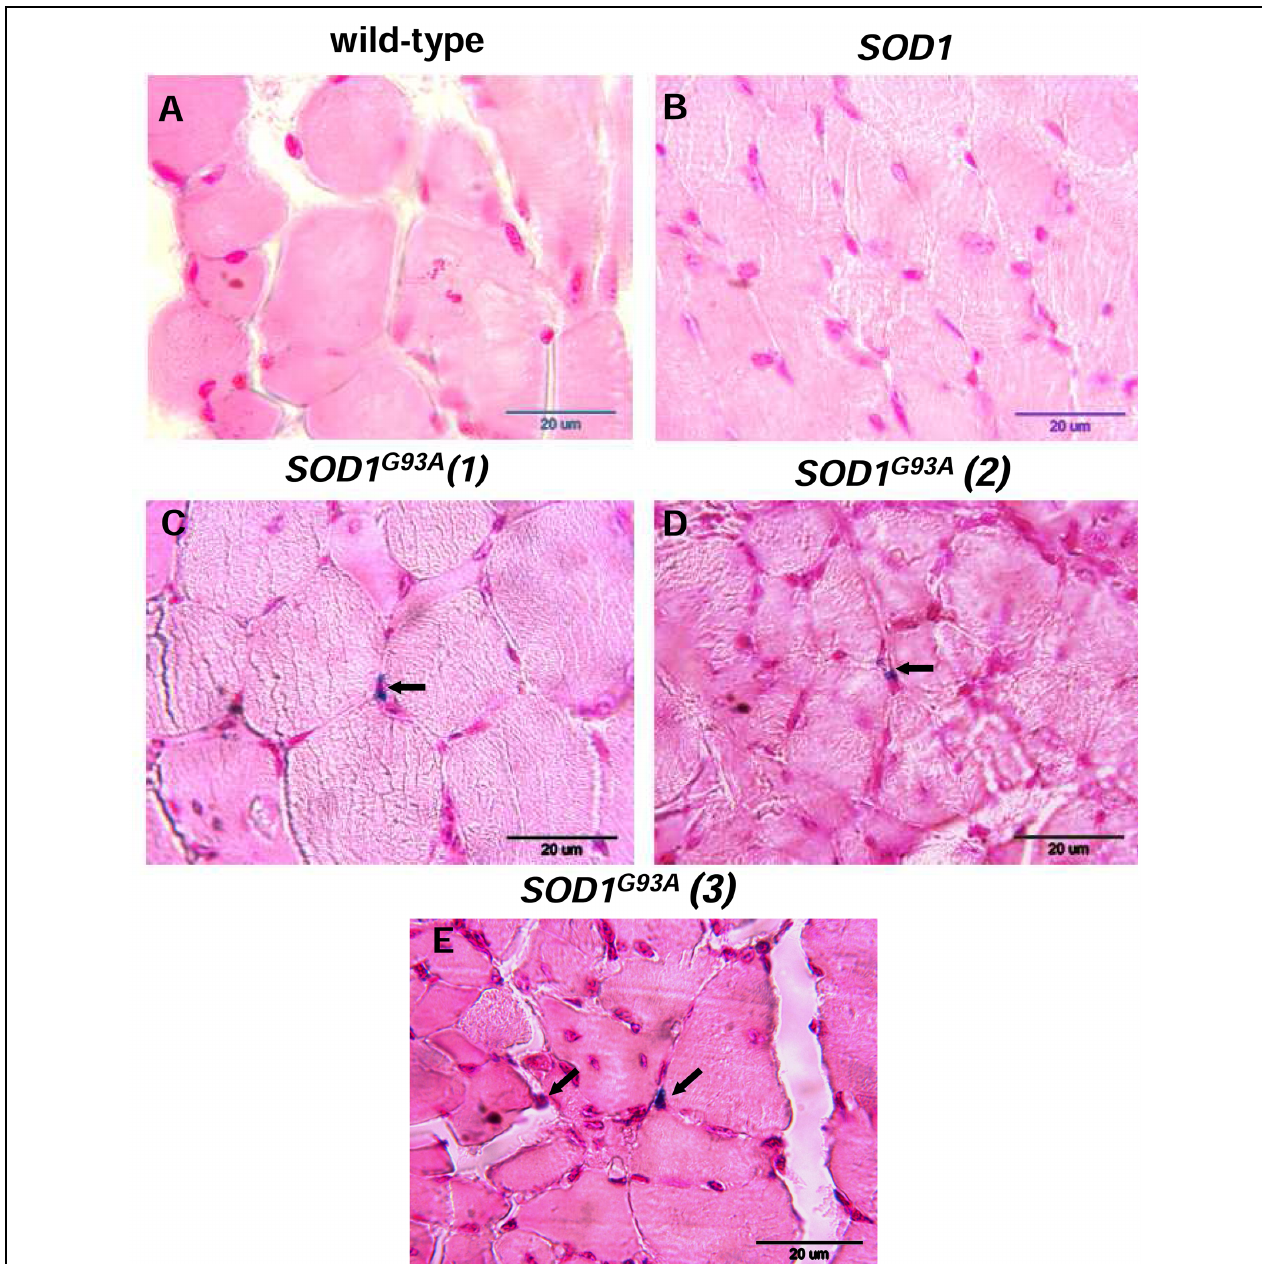
FIGURE 3 | Histological examination of iron loading in the gastrocnemius muscle of 4-month-old experimental mice. Non-heme iron deposits were detected by staining with Perls Prussian Blue in the gastrocnemius muscle of wild-type (A) and SOD1 mice (B) . Blue staining (indicated by arrows) was present exclusively in the muscle section of symptomatic SOD1 G 93 A mice. Staining of muscle sections from three SOD1 G 93 A mice are shown (C,D,E)